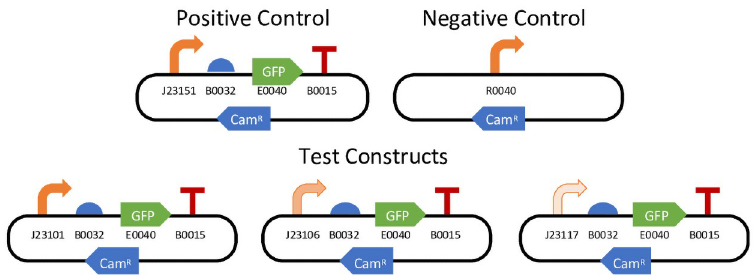
Fig 1. Constitutive fluorescence genetic constructs measured in all three of the 2016, 2017, and 2018 iGEM Interlab Studies, diagrammed using standard SBOL visual symbols